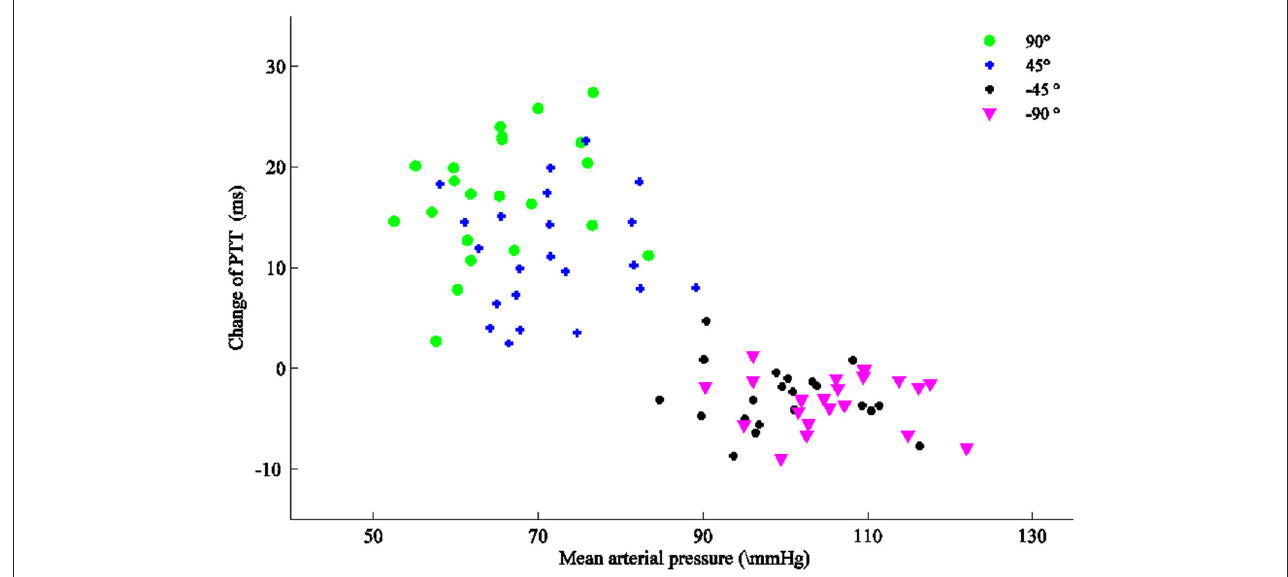
FIGURE3 Relationship between each subject’s changes in the pulse transit time (PTT) and corresponding mean arterial pressure (MAP) with the arm at 90, 45, − 45, and − 90 o , respectively.